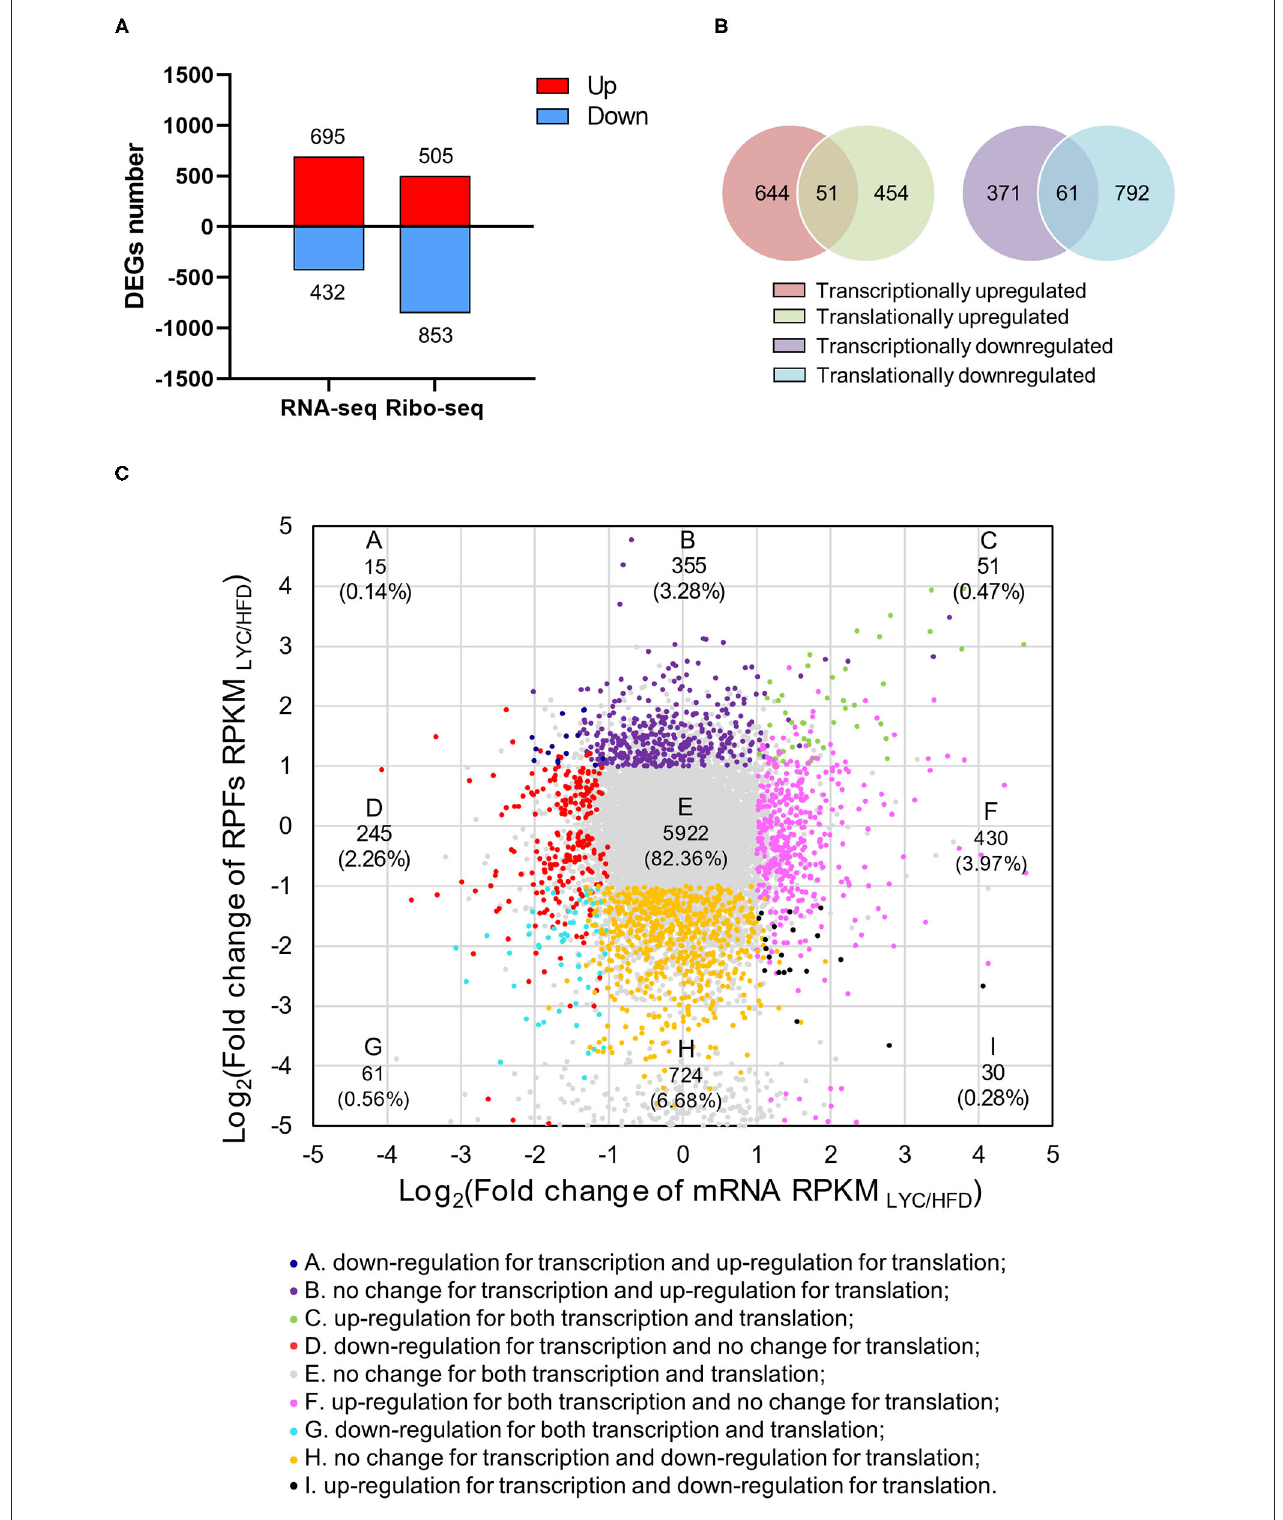
FIGURE 5 | Lycopene altered gene expression at both transcriptional and translational levels. (A) Number of DEGs (|log 2 fold change| ≥ 1 and p < 0.01) at transcriptional or translational levels. The red and blue bars refer to the number of upregulated and downregulated genes, respectively. (B) Venn diagram showing the relationship between transcriptome and translatome. (C) Fold changes of RPKMs at transcriptional and translational levels. Nine squares in different colors indicate nine responsive groups (|log 2 fold change| ≥ 1 and p < 0.01).